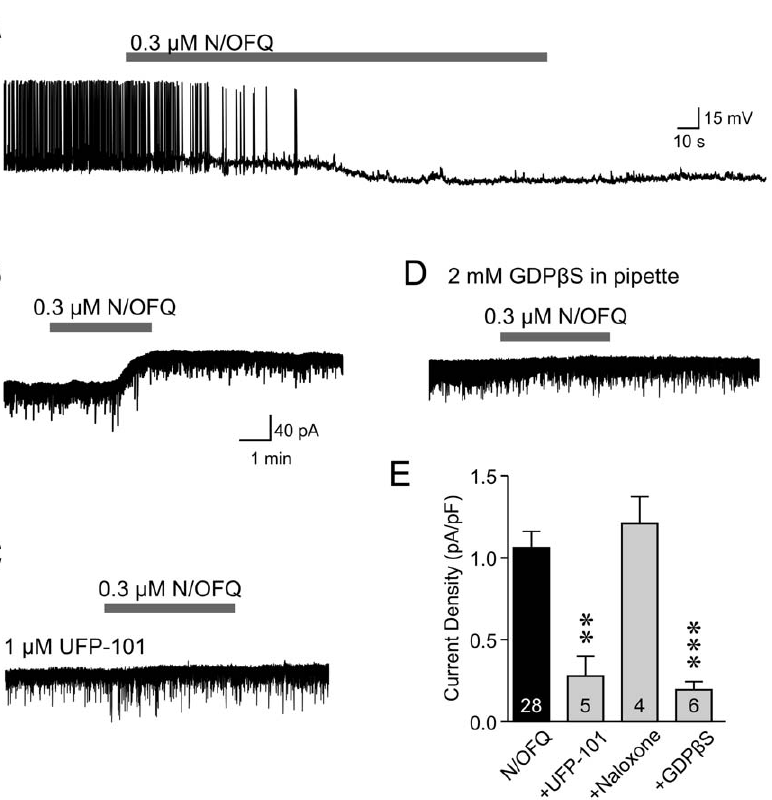
Figure 2. N/OFQ inhibits orexin neurons via NOP receptor activation in the rat. A : N/OFQ hyperpolarizes orexin neurons. B : Representative voltage clamp trace showing a TTX-insensitive outward current induced by N/OFQ application. C : N/OFQ-induced effect is significantly attenuated by UFP-101. However, the effect persists in the presence of naloxone (E), indicating a specific activation of NOP receptors. D: N/OFQ is ineffective on orexin neurons patched with GDP b S in the recording pipette. E: Grouped data is shown. Numbers in bars represent the number of cells examined in each group. ** p , 0.01, *** p , 0.005 vs. N/OFQ.